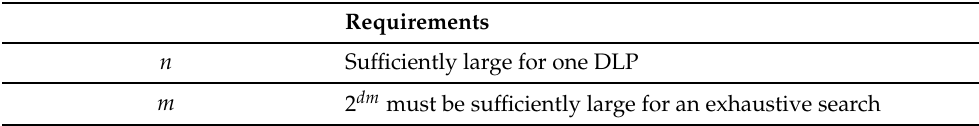
Table 3. Requirements for n and m